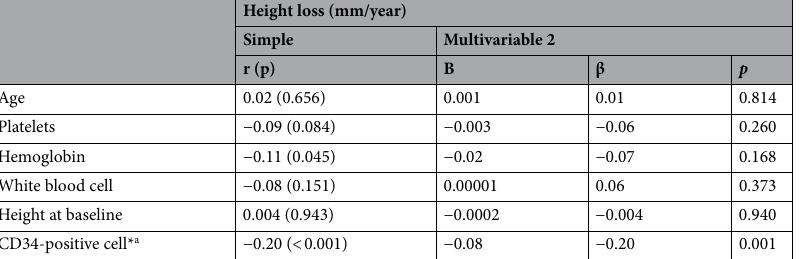
Table 4. Correlation between height loss as a continuous variable and circulating CD34-positive cell count adjusted for hematological parameters and height at baseline. r: simple correlation coefficient. Β: parameter estimate. β: standardized parameter estimate. Multivariable 2, adjusted only for age, hematological parameters (white blood cell, platelets, hemoglobin), and height at baseline. *a: Logarithmic transformation were